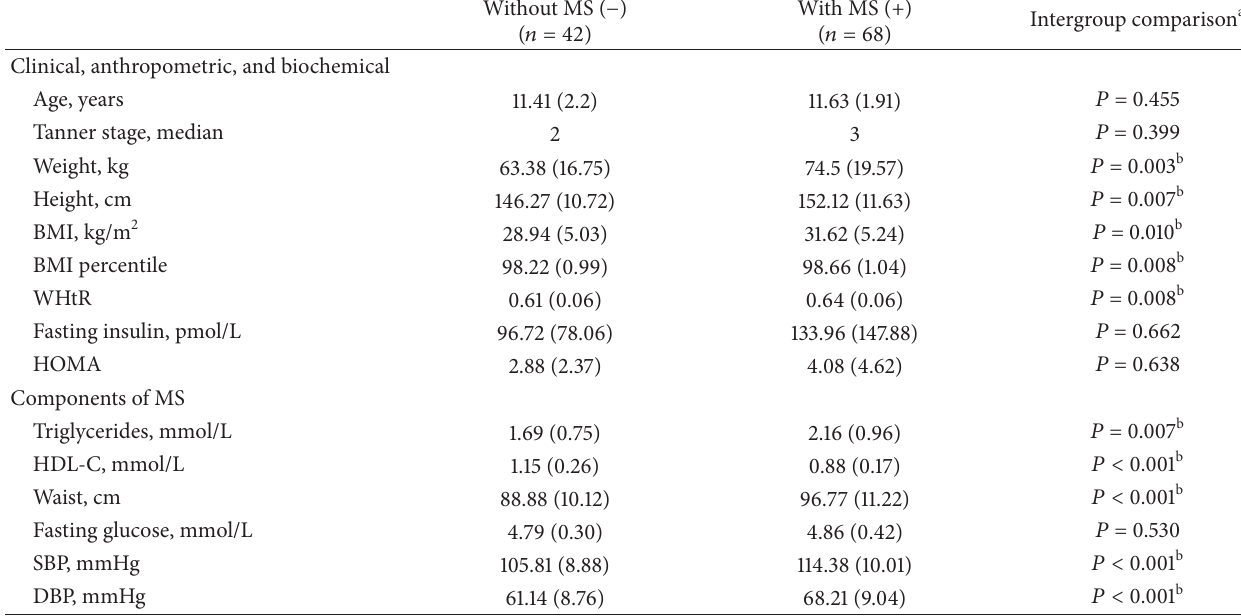
Table 1: Characteristics of the study population, grouped by the presence or absence of metabolic syndrome. Without MS ( − )